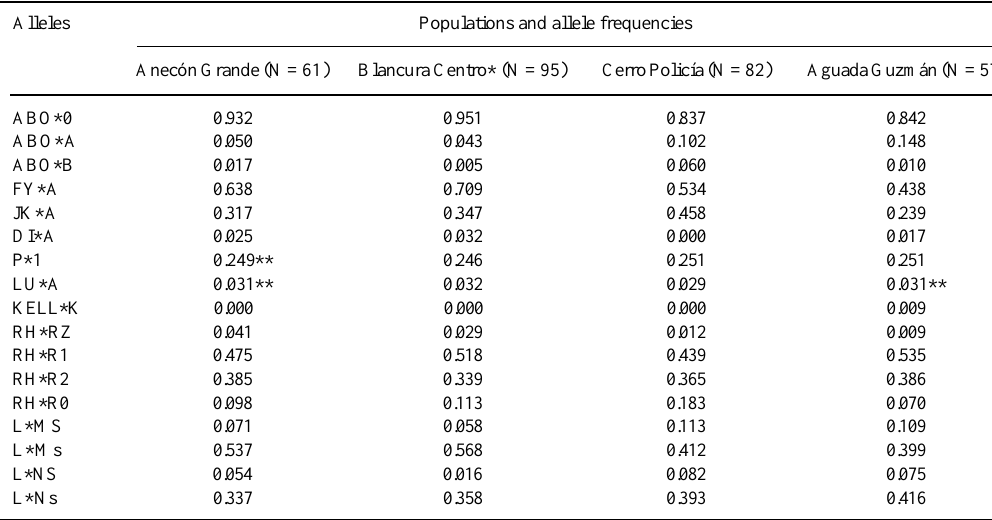
Table III - Blood group allele frequencies in the Indian populations